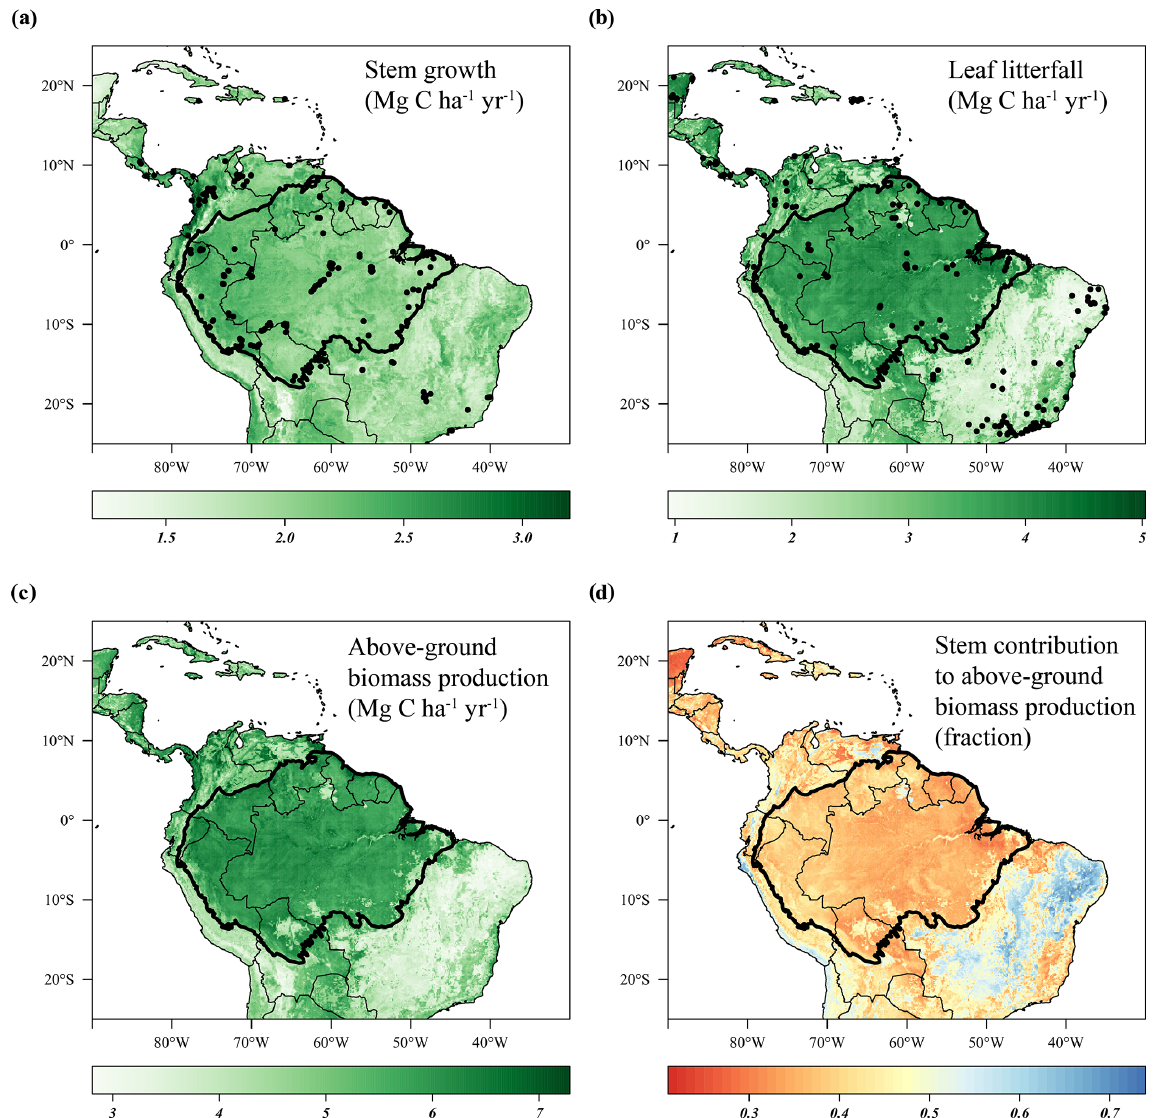
Figure 2. Predicted stem growth (a) , leaf litterfall (b) , and total above-ground biomass production (c) and the contribution of stem growth to the above-ground biomass production (d) across the neotropics from 1982 to 2019. Site locations where stem growth ( n = 458) (a) and leaf litterfall ( n = 377) (b) were measured are depicted as solid black circles. Country borders and the extent of the Amazon basin are marked by thin and thick black lines,